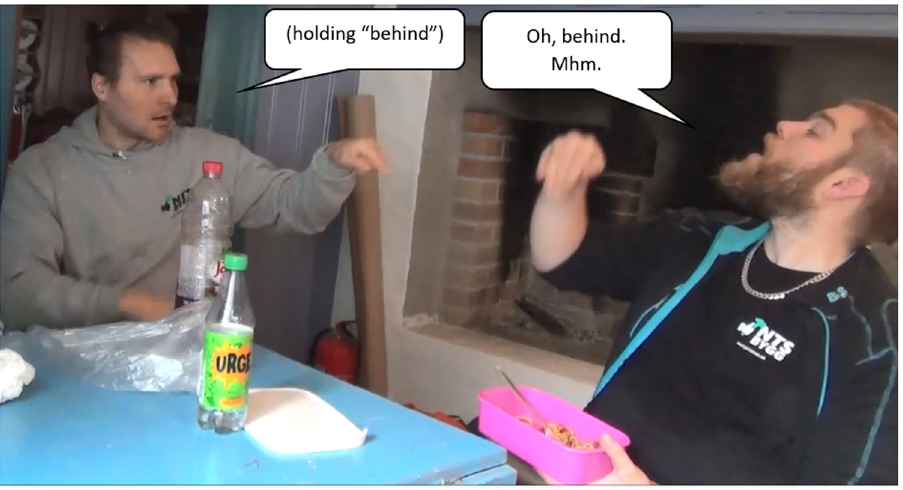
Figure 8: Display of understanding by other repeating “ behind ” and doing an upward nod. ( End of lines 14 and 15.